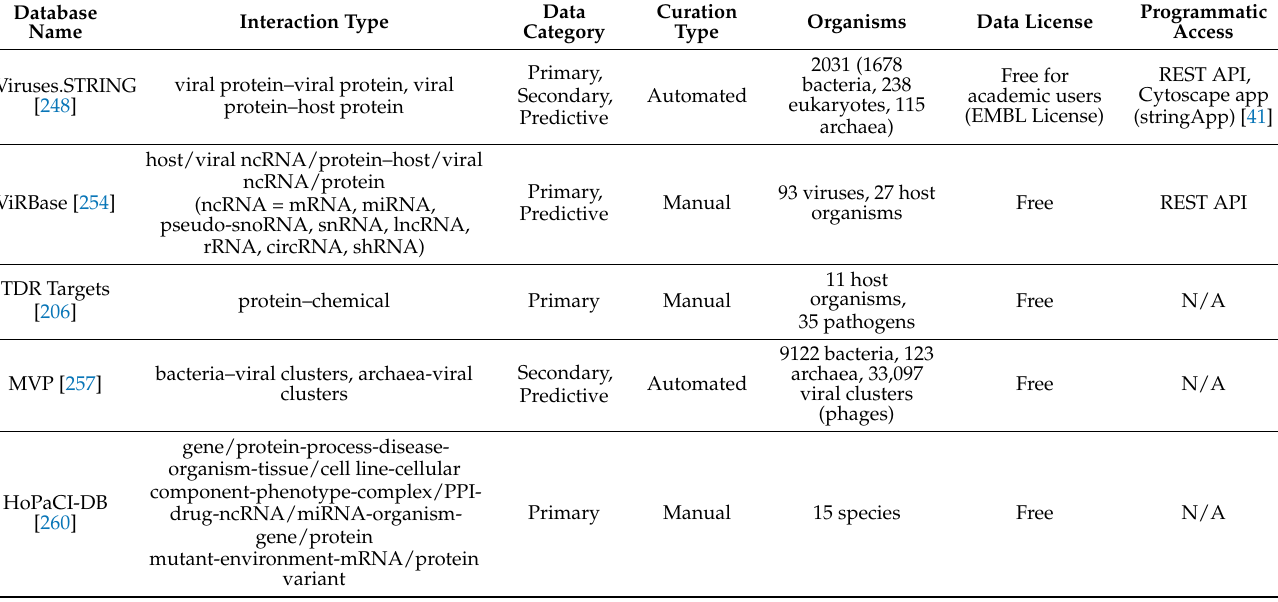
Table 9. Host–pathogen interactions